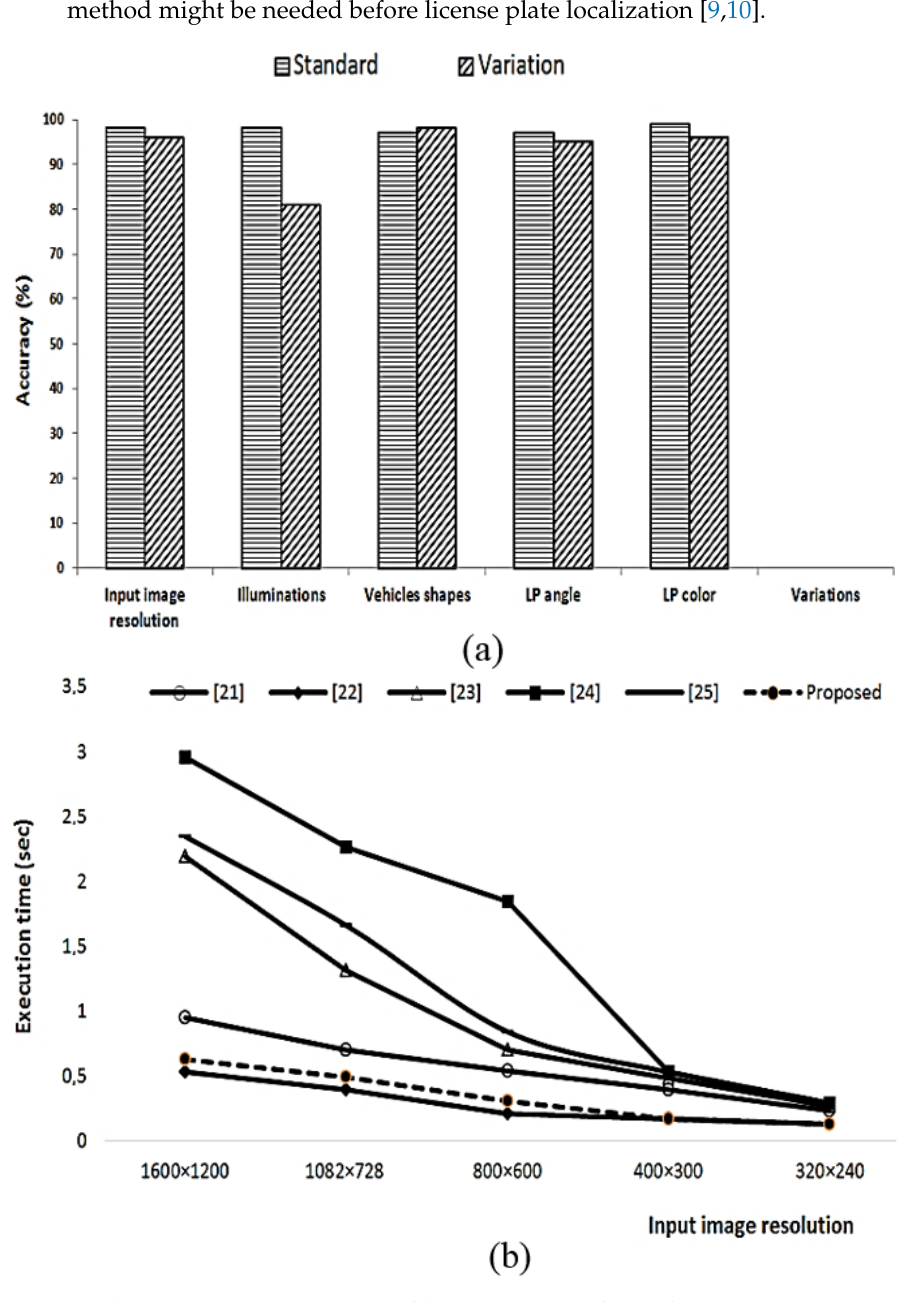
Figure 5. ( a ) Variation in parameters and ( b ) Computational complexity